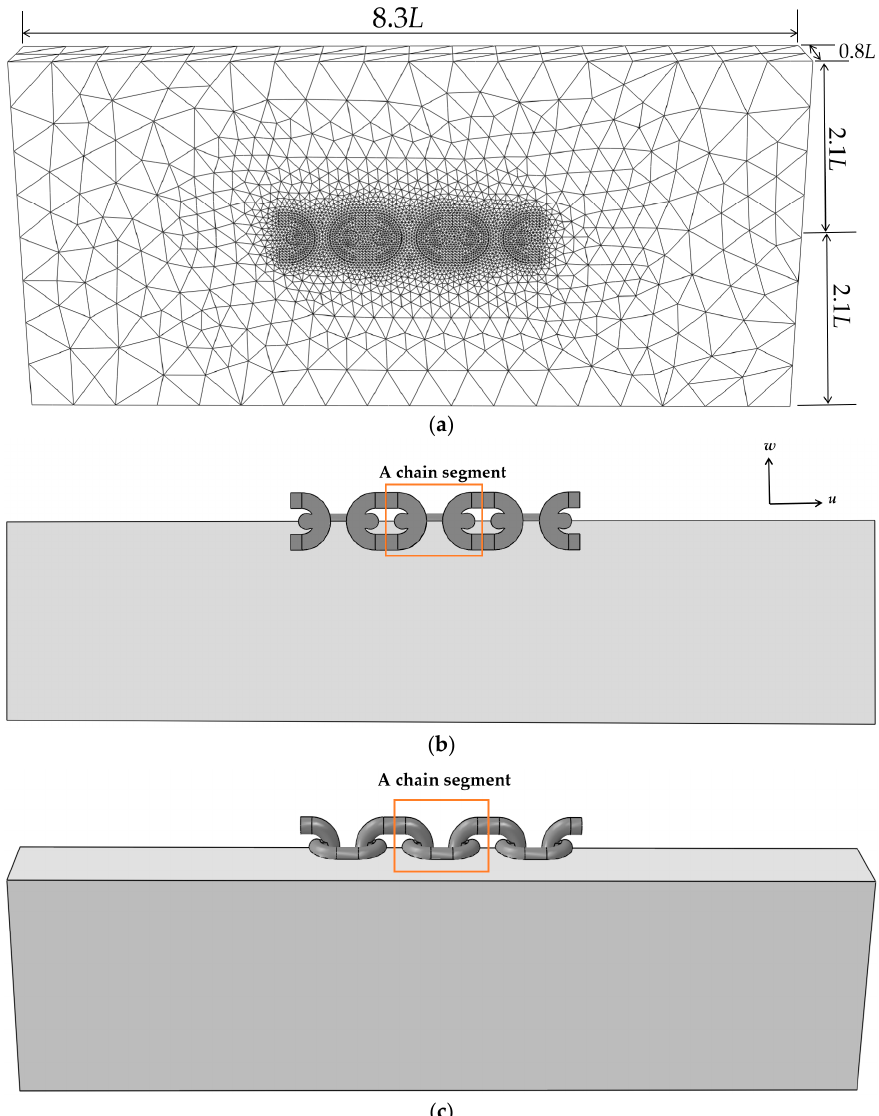
Figure 2. The chain and soil model: ( a ) front view of the whole model mesh; ( b ) front view of the half-model to highlight the chain geometries; ( c) side view of the half-model to highlight the chain geometries.